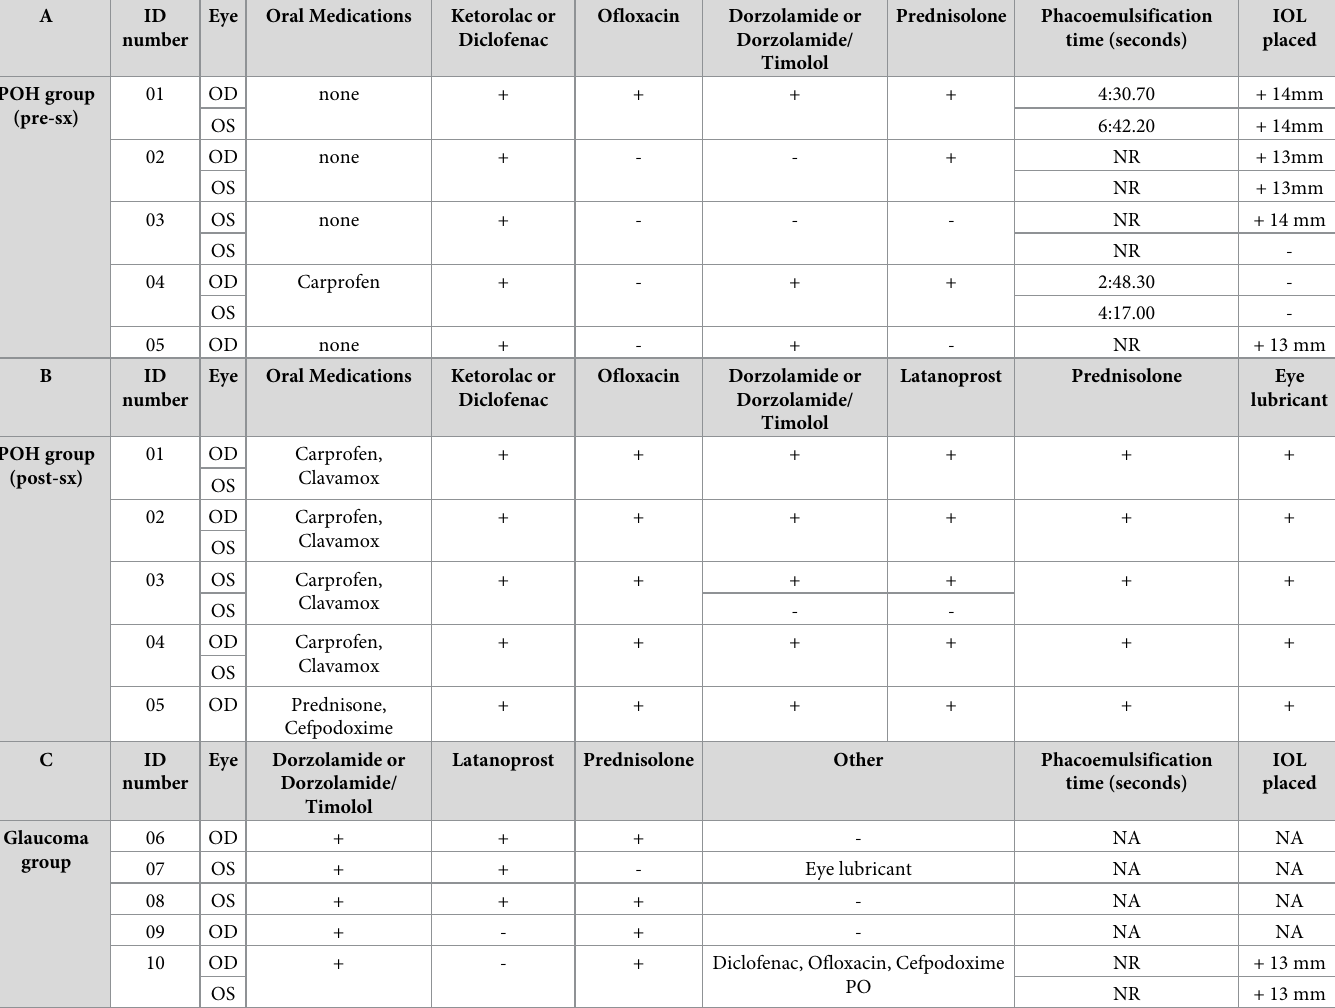
Table 2. Pre- and post-operative surgical information for the ‘POH group’ and ‘glaucoma